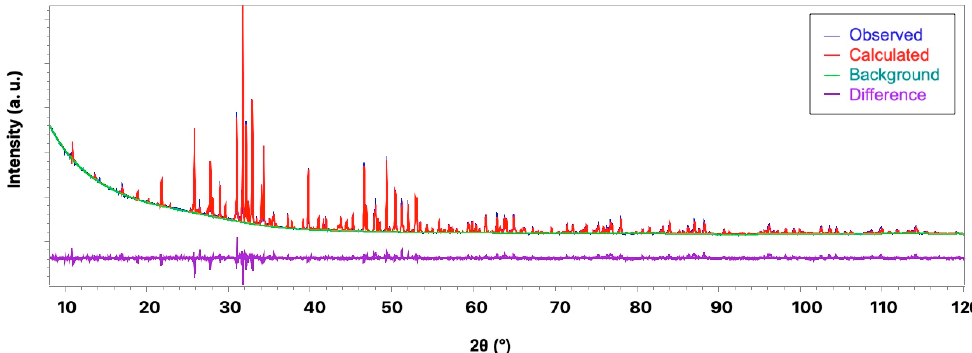
Figure 6. Rietveld plot of Dop3 sample. Observed diffraction profile (blue line), calculated profile (red line), background (green line) and difference profile (violet line).